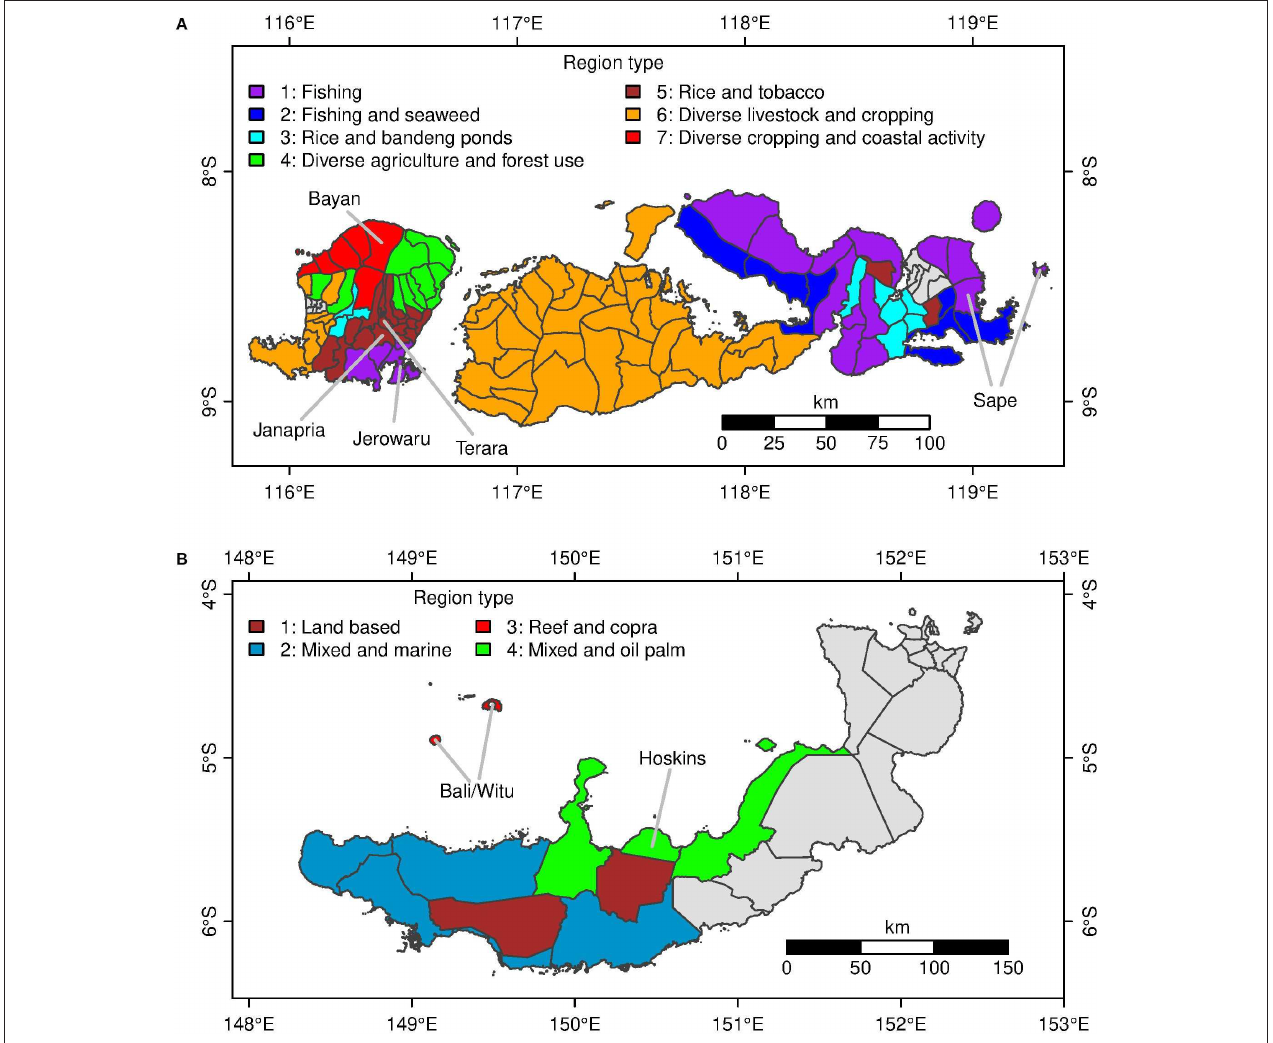
FIGURE 4 | The resource use typologies for rural sub-districts in (A) NTB and (B) WNB, and case studies where adaptation planning was carried